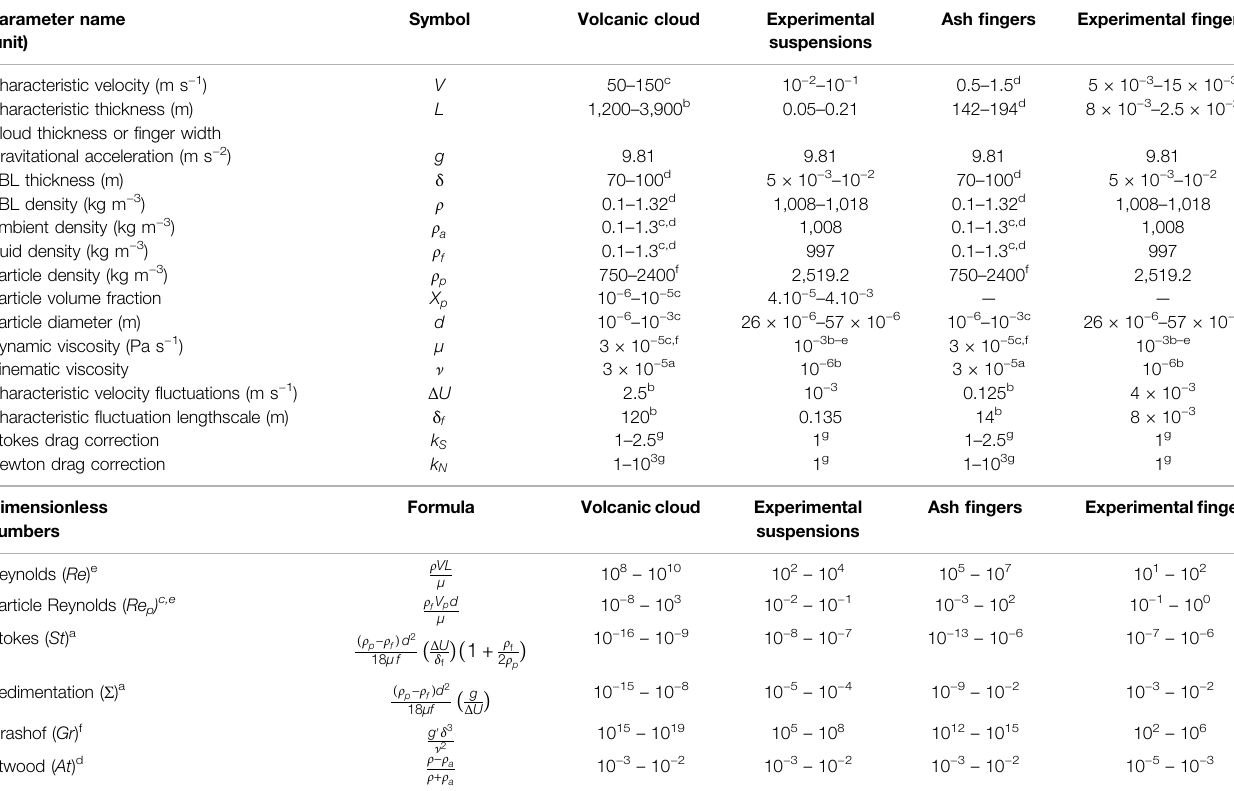
TABLE 1 | Top - Typical dimensional parameter ranges for the variables used in the scaling analysis for both natural and experimental